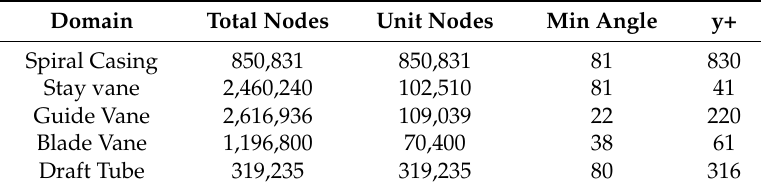
Table 1. Mesh Description. y+: Non dimensional wall